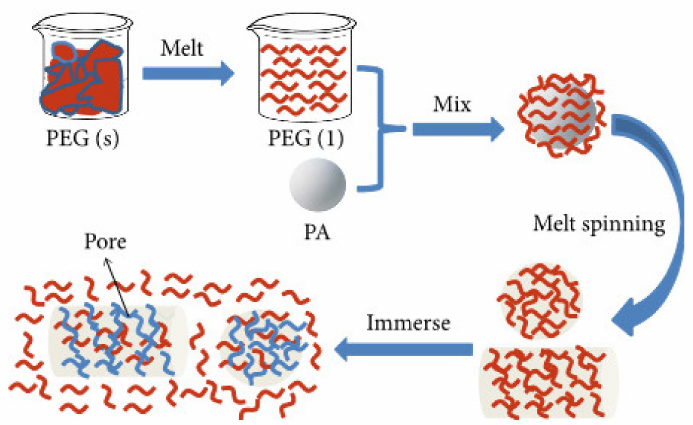
Figure 6. Schematic showing the melt spinning porous polyamide fibers. Reproduced under the terms and conditions of the liberal Creative Commons Attribution 4.0 International (CC BY) license from [61]. Published by Hindwi. Copyright © 2020 The